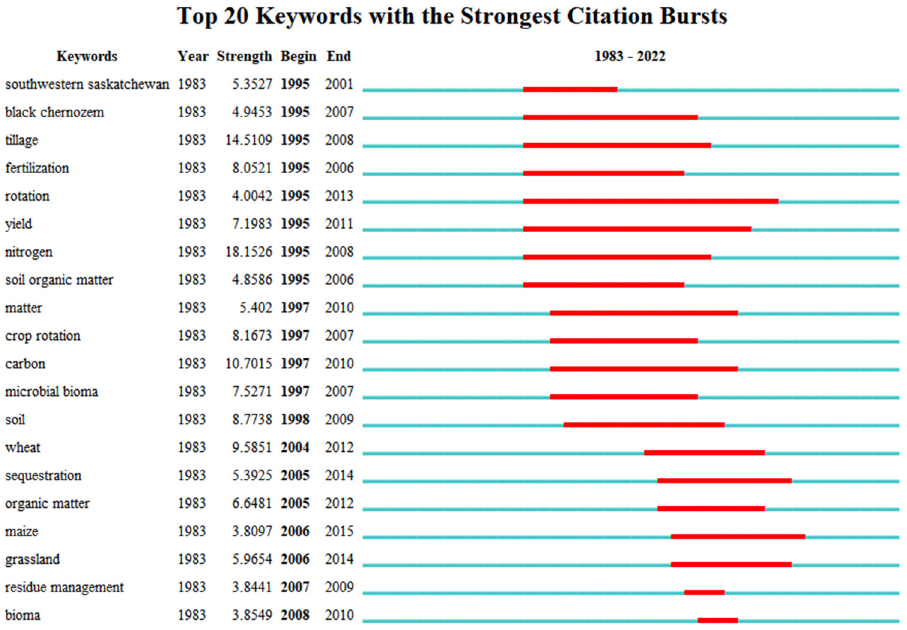
Figure 8. The top 20 high-frequency keywords in the BSC research area and their occurrence times. Among them, “year” represents the starting time set in this study; “intensity” represents the intensity of the keyword outbreak; “start” and “end” represent the starting and ending years of the keyword emergence respectively; the red part of the line represents the emergence time.